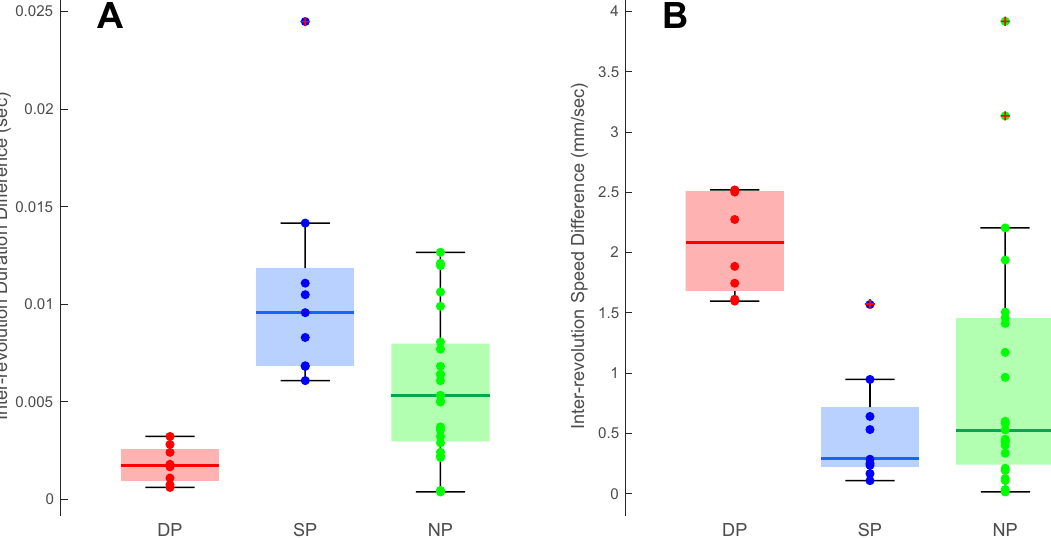
Figure 6. Inter-revolution differences. Box plot representing the group inter-revolution differences for duration ( A ) and for speed ( B ). It is possible to see that, for duration, DP group (red) presents very small differences compared to SP (blue), suggesting that DP group maintains the duration relatively constant. The opposite trend is visible for speed in which the SP group (blue) presents smaller differences compared to the DP group (red). The NP groups presented intermediate values for both duration and speed (green). The colored dots superimposed on the plots represent the individual subject and are color coded according to their group (red for DP group, blue for SP group, and green for NP group). Crosses represent extreme